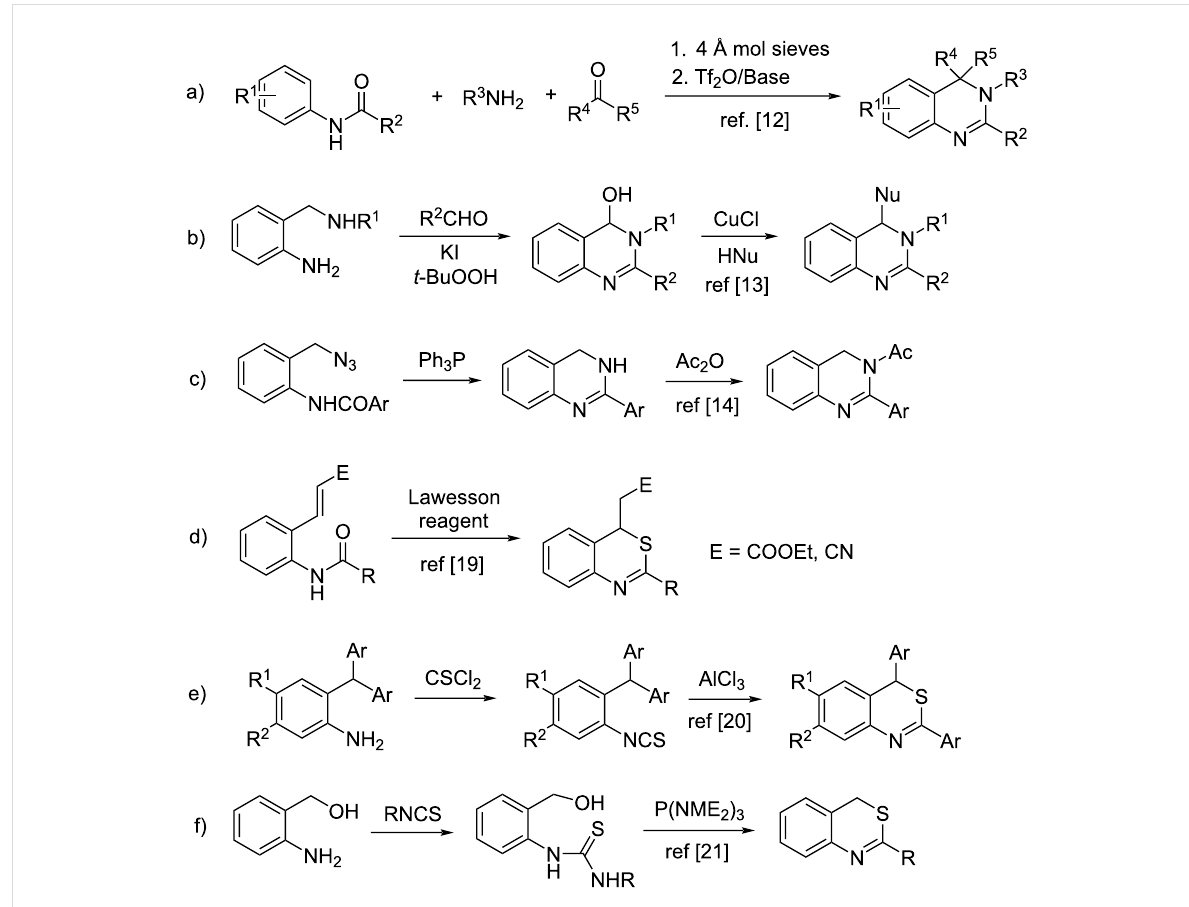
Scheme 1: Representative preperation of 3,4-dihydroquinazolines and 4 H -3,1-benzothiazines.